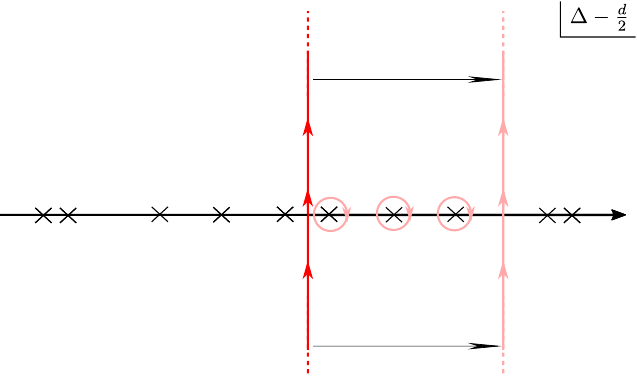
Figure 5 . A contour deformation which produces the conformal block expansion (4.10) from the spectral decomposition (or equivalently the conformal partial wave expansion) (4.8). After rewriting the integrand, we can move the contour of integration to the right half plane. As a result, the integral picks up contributions from poles, which generate the conformal block expansion. Figure 6 . States in EAdS and dS. Left : states defined on a constant time slice in global AdS can be mapped to states defined on a hemisphere anchored at the boundary of AdS. The radius of the hemisphere shrinks to a point on the boundary under the action of dilatations. This provides an intuitive explanation of the state-operator correspondence. Right : states defined on a constant time slice in global dS. Unlike in AdS, there is no way to relate the time-slice to a point at future infinity using the action of the dS isometries. See more discussions in section